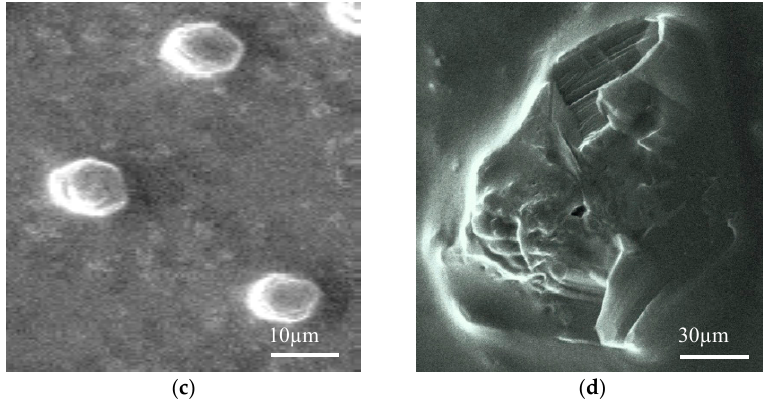
Figure 6. ( a ) SEM micrographs of untreated E. coli ; ( b ) E. coli cell treated with a combination of BCN E 50-52 and thymol at FIC values; ( c ) SEM micrographs of untreated S. aureus ; ( d ) S. aureus cell treated with a combination of BCN E 50-52 and thymol at FIC values.